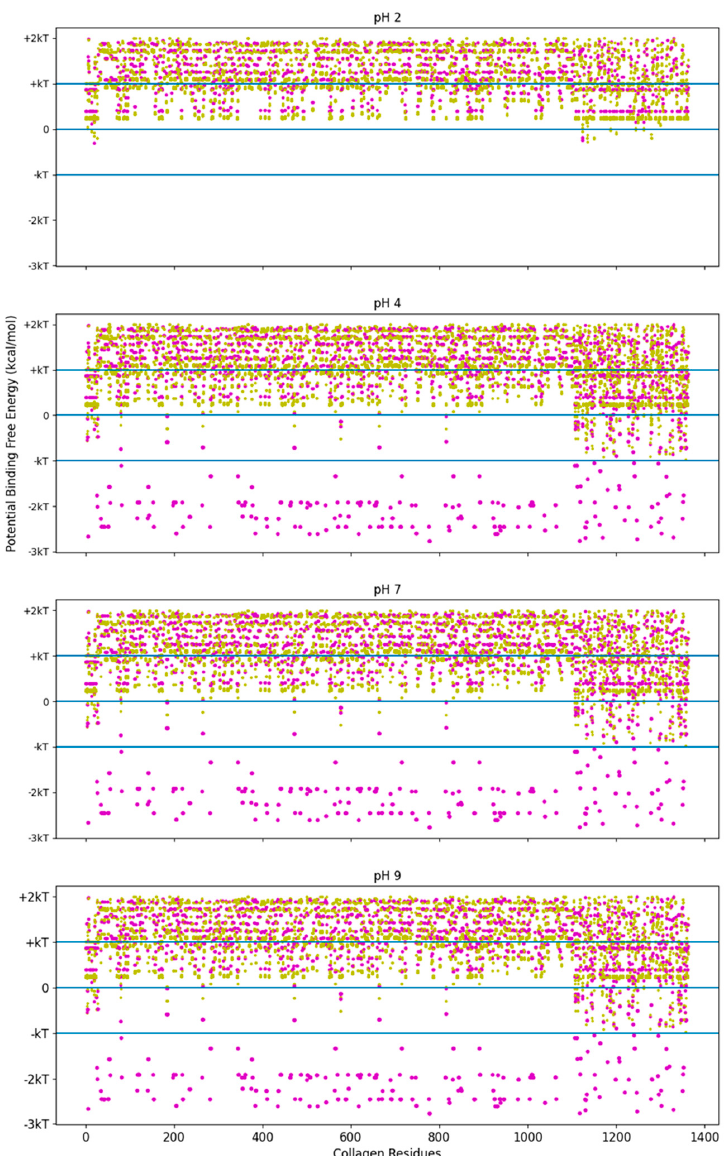
Figure 6. Free energy of binding estimates for sets of three adjacent residues for three different collagen-binding peptides for all residues of human collagen type I alpha chain 2 (COL1A2). Positive binding sites are energetically unfavorable, while negative binding sites are favorable. Binding sites significantly below − kT are likely to be stable. Each circle represents a potential three-amino-acid binding site between a peptide and collagen. The potential binding free energy was calculated from the Wimley–White hydropathy scale values for the amino acids within the binding site. The potential binding sites are magenta for COL1A2 Sense Peptide (TKKTLRT) and gold for collagenase sub-sequence (SQNPVQP). While neither peptide sequence has amino acids which a change state at different pH levels, the COL1A2 does have residues which are pH dependent. At pH 2, only E0 and D0 residue states are available. The alkaline residues of TKKLRT cannot interact with these uncharged residues, nor can the protonated histidine residues. At pH 4 and more alkaline pH values, the E0 and D0 residues can become charged, resulting in many strong interactions along the COL1A2 sequence and the alkaline side chains of TKKTLRT. kT, which is the Boltzmann’s constant multiplied by the temperature of 25 ◦ C, is 0.693 kcal/mol. This value is close to a mean estimate of the free energy fluctuations of a surrounding environment near room